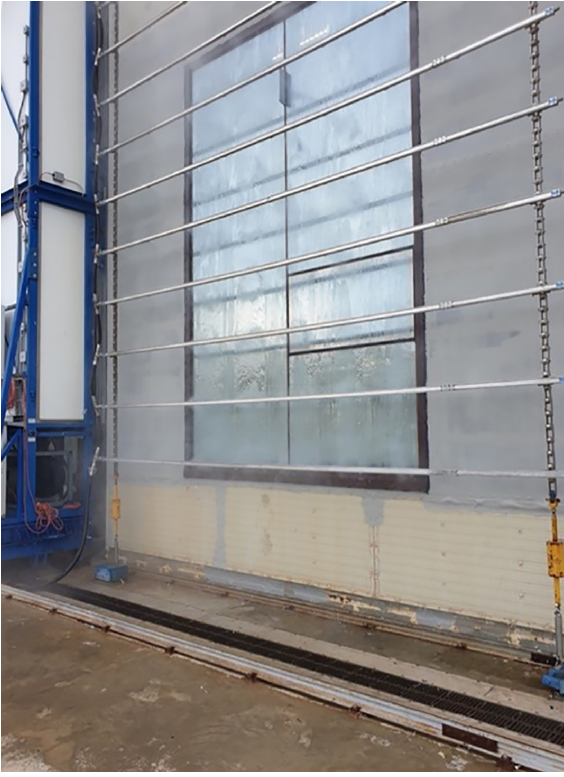
Figure 3. Watertightness performance under static pressure on mock-up 01.